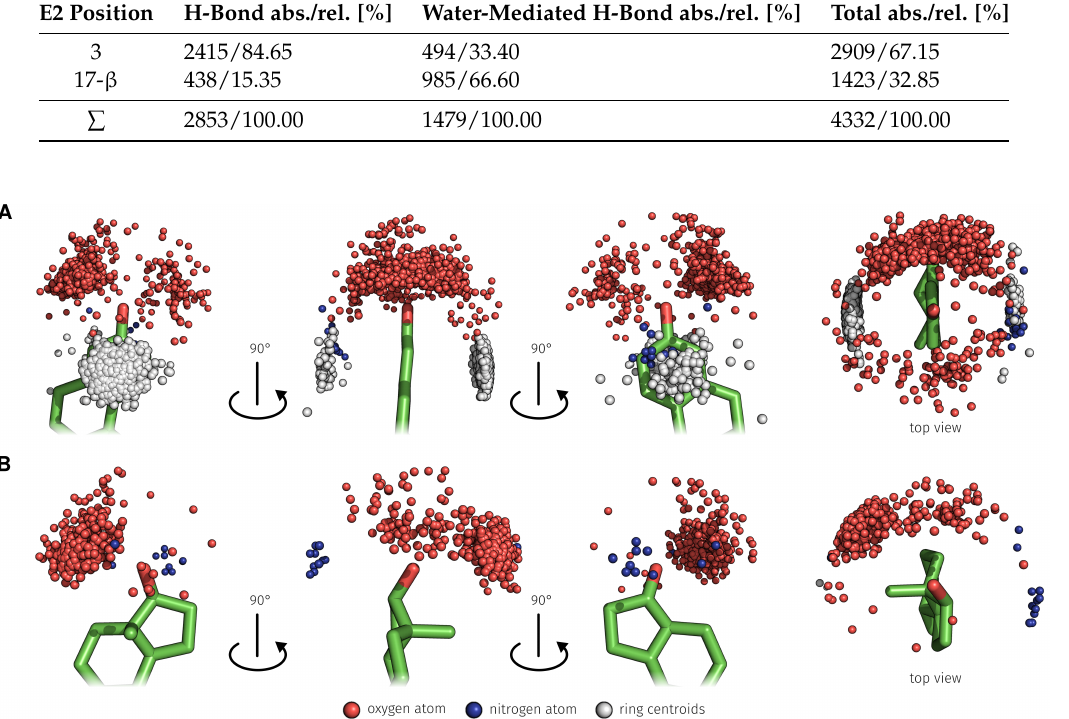
Table 3. Overview of the detected interactions between 3- and 17- β -position during the 25 ns MD simulation. The absolute (abs.) and relative (rel.) frequency of the detected H-bonds and water-mediated H-bonds are displayed. The last column lists the total number of interactions per E2 position. E2, 17 β -estradiol; H-bonds, hydrogen bonds. E2 Position H-Bond abs./rel. [%]